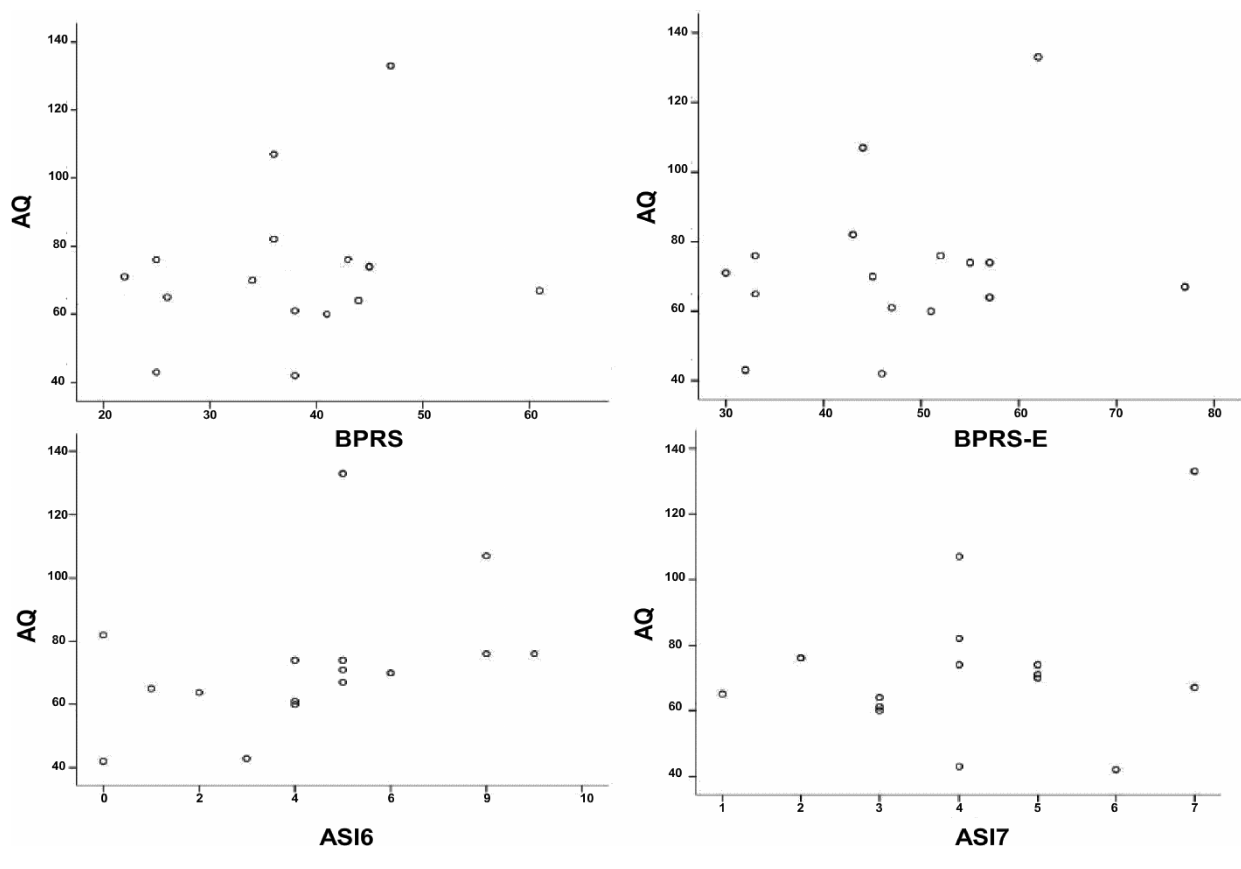
FigurE 2 | relationships between aggression questionnaire (AQ) and brief psychiatric rating scale (BPrS), expanded BPrS (BPrS-E), addiction severity index 6 (ASi 6), ASi 7, in the 16 alcoholic patients at baseline. No significant correlations were found between AQ and either BPRS or BPRS-E (top panel), and between AQ and either ASI 6 or ASI 7 (bottom panel) ( p >